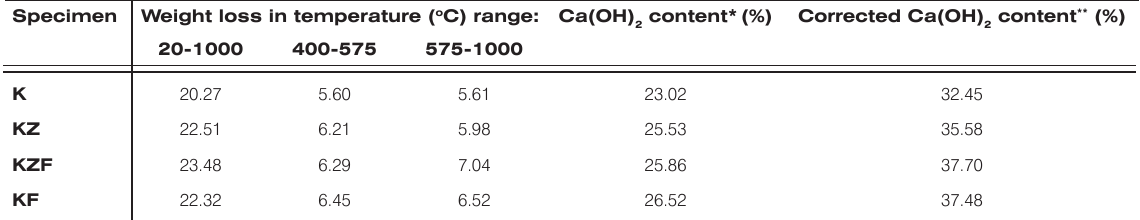
converted in CaCO (based on weight loss 2 3